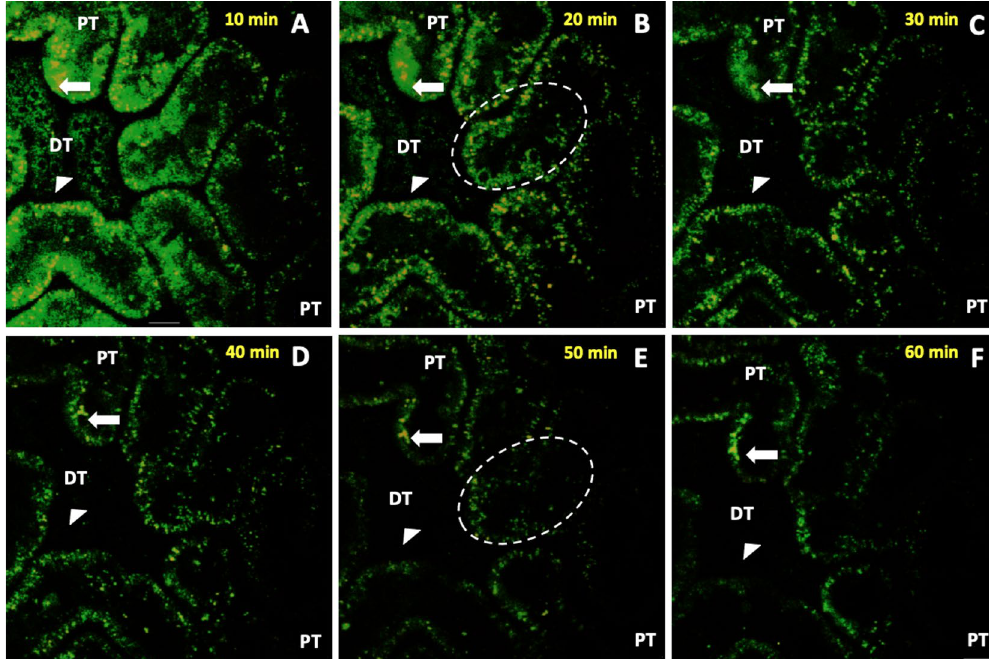
Figure 6. Time-lapse images tracked alterations in actin-based fluorescence observed during the first 60 min of reperfusion. Intravital two-photon micrographs were taken with a ×60 objective from a live rat in group 4 across 60 min (this is the same imaging field that is previously presented in Fig. 3D). This animal received HGD and was subjected to ischemia-reperfusion injury (IRI). All images were formed by merging the green- and red-pseudo-color channels and shows the expression of EGFP actin in both proximal and distal tubules. This fluorescent protein expression allowed us to visualize the live and real-time changes in tubular structure and function that resulted from IRI (arrows identified changes in proximal tubules, and arrowheads identified changes in distal tubules). At the 10-min mark, EGFP-actin appeared more heterogeneously distributed and clumped in tubular segments. The dashed ovals in ( B and E ) track the outlined region and show how cells have sloughed off the proximal tubule segment and migrated into the lumen to generate ghost tubules (tubules mostly devoid of living cells) by the 50-min mark. It should be noted that there were minor shifts in the field during the 60-min imaging period that resulted from the vibration caused by respiration. Scale bar represents 20 µm. A time-lapse video showing portions of this event is presented in Supplemental Video